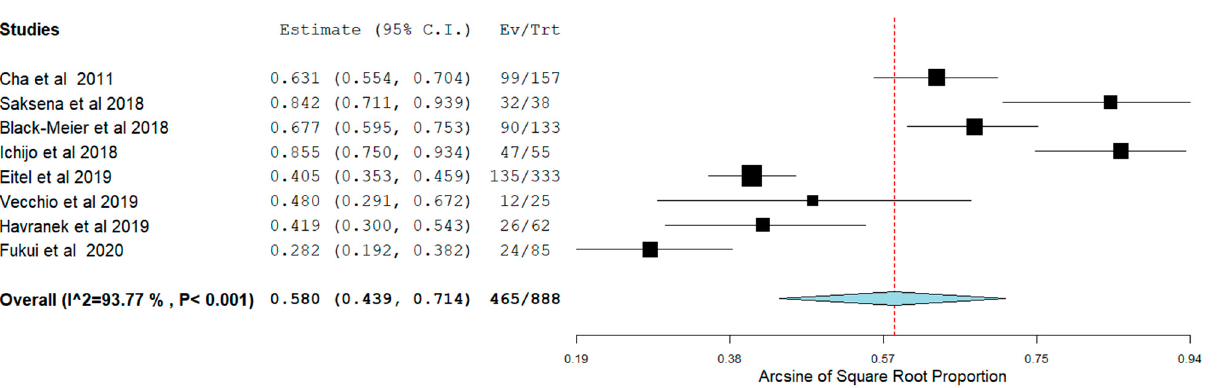
Figure 4. NSR post-ablation without AAD.